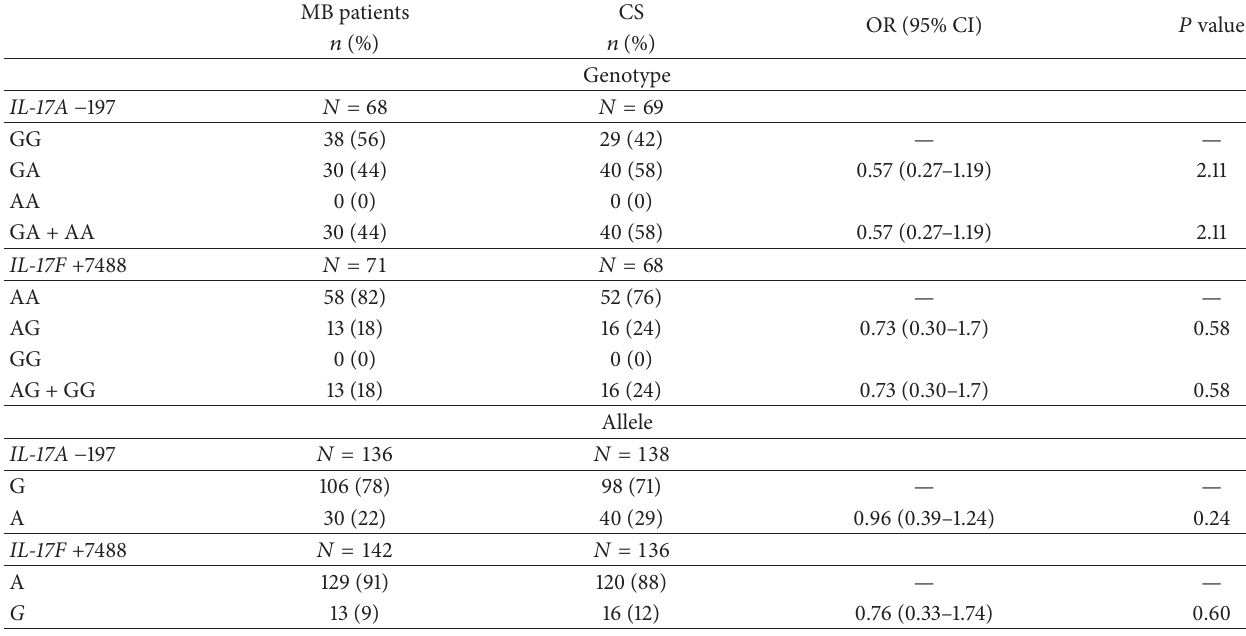
Table 1: Allelic and gene frequencies of polymorphisms in IL-17A and IL-17F genes in patients with multibacillary leprosy and healthy